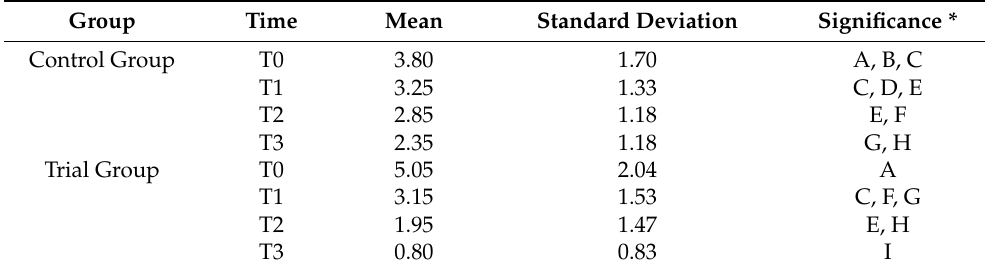
Table 4. Descriptive statistics of VAS measurements.